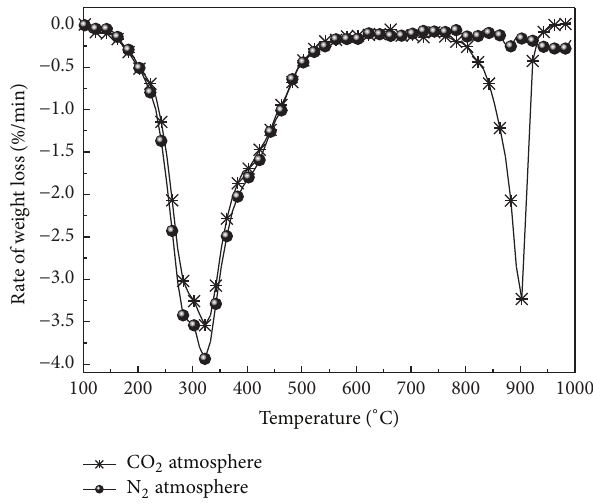
Figure 2: DTG curves of Chlorella vulgaris decomposition at a heating rate of 10 ∘ Cmin −1 in N 2 and CO 2